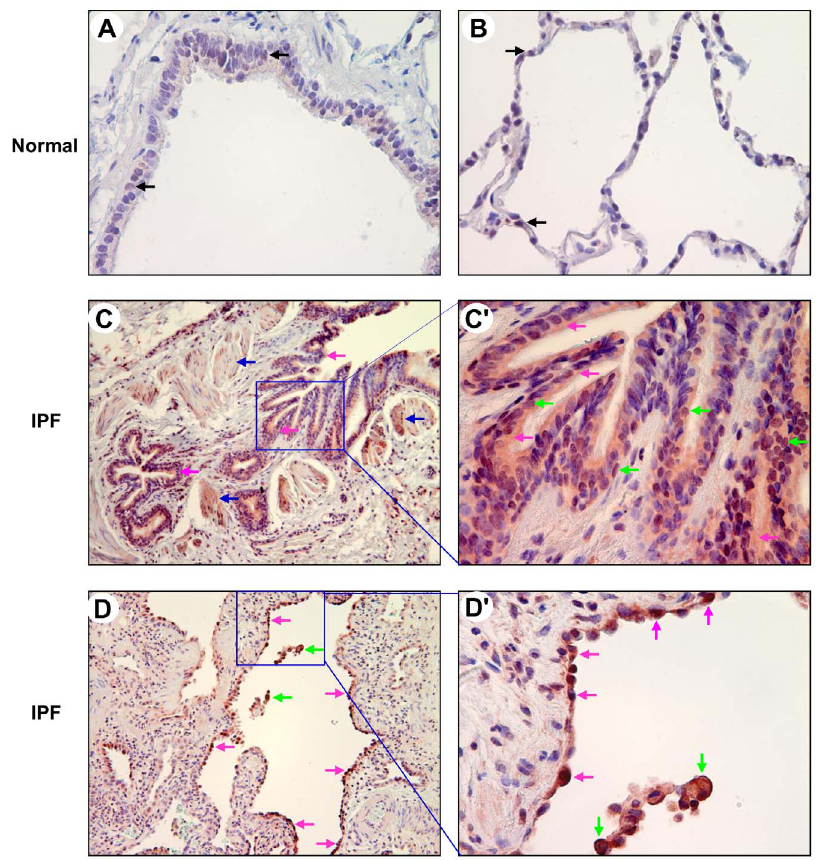
Figure 4. Expression of PKD3 in normal and IPF lung tissues. Normal and IPF lung sections were subjected to immunohistochemical analysis by a PKD3 specific antibody at a dilution of 1:500. A and B: normal lung BECs and AECs (black arrows) were weakly stained in the nuclei by the PKD3 antibody. Final magnification: 6 400. C and C 9 : in IPF bronchi, PKD3 (red) was expressed in the cytoplasm (pink arrows) and nuclei (green arrows) of BECs and in smooth muscle cells (C, blue arrows). The region indicated in panel C ( 6 100) is shown at higher magnification in C 9 ( 6 400). D and D 9 : in the fibrotic areas of IPF lung, PKD3 (red) was expressed in the cuboidal regenerative AECs (pink arrows) lining remodeled fibrotic alveolar septa and/ or fibroblast foci and in macrophages (green arrows). The region indicated in panel D ( 6 100) is shown at higher magnification in D 9 ( 6 400).